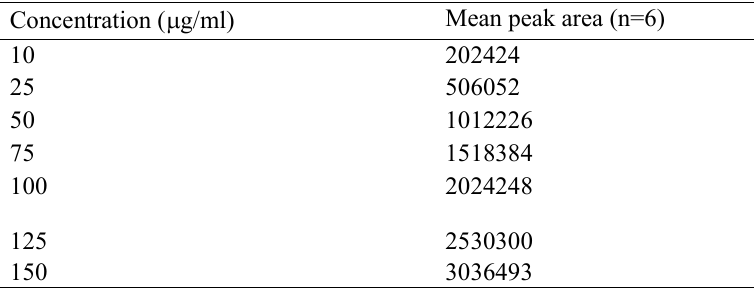
Table 1: Calibration data of the method.